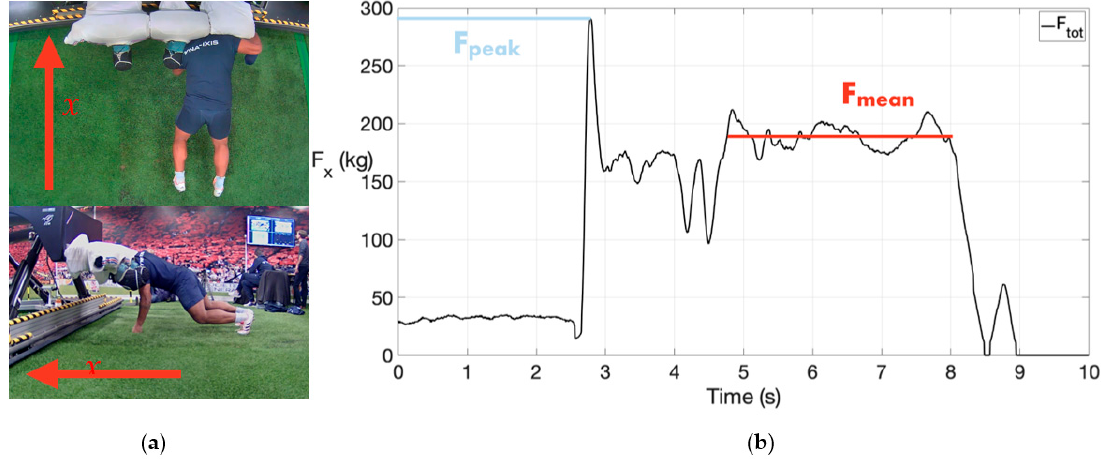
Figure 2. Example of a single player pushing against the scrum machine. ( a ) Zenithal and side view of Number-5 lock experiment. ( b ) Compression force in function of time. 𝐹 (cid:3043)(cid:3032)(cid:3028)(cid:3038) is defined as the maximal value reached during the engagement. 𝐹 (cid:3040)(cid:3032)(cid:3028)(cid:3041) is given by the higher averaging of the force made with a window of 1.8 seconds on the